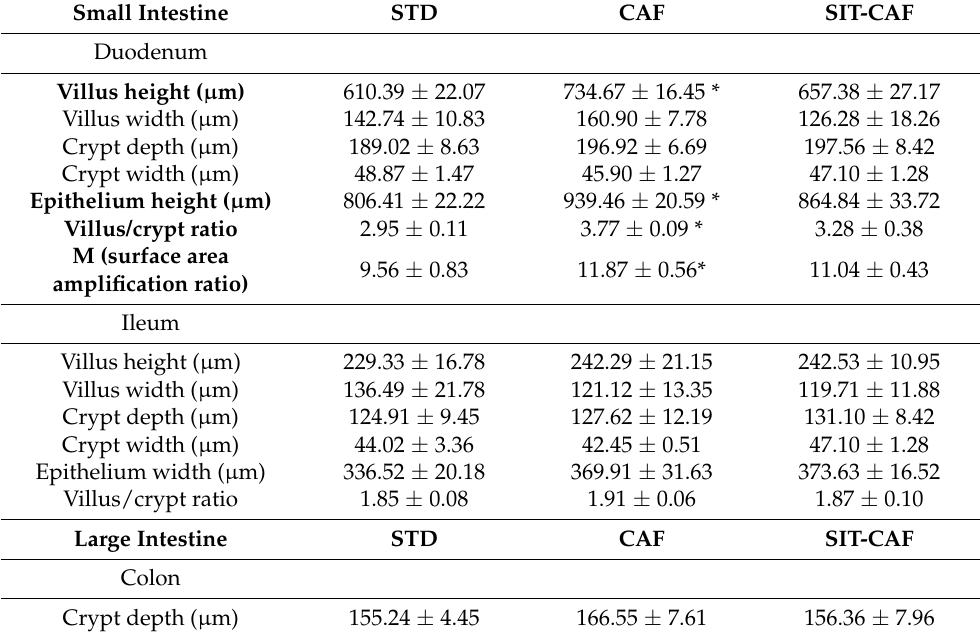
* indicate the statistically significant differences with respect to standard diet group ( p < 0.05) by Student t